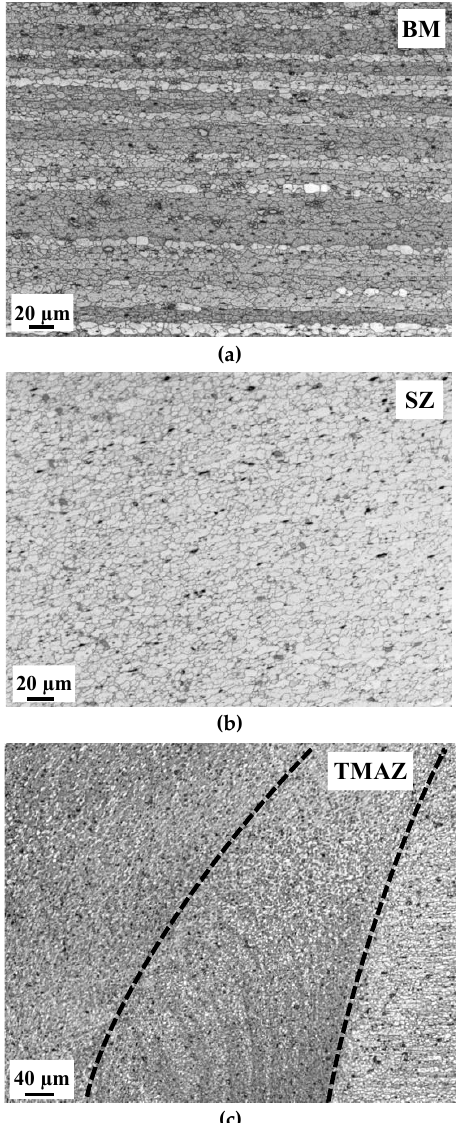
Figure 3. Optical micrograph images of the FSP AA6082 sample: ( a ) BM; ( b ) SZ and ( c ) TMAZ.